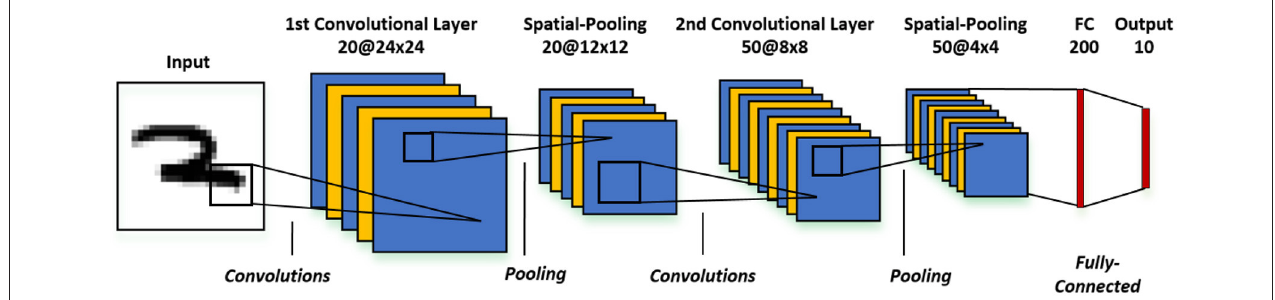
FIGURE 1 | Architecture of the multi-layer convolutional spiking neural network consisting of an input layer, alternating convolutional and spatial-pooling layers, and final fully-connected layers for inference.